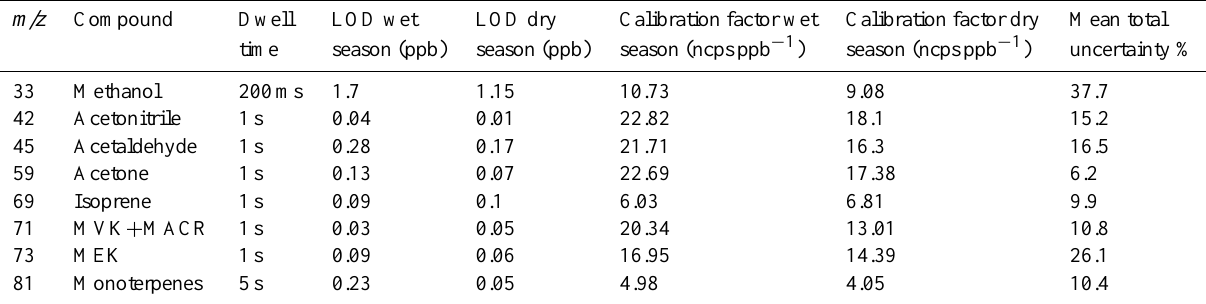
Table 1. Compounds calibrated for PTR-MS measurements with respective protonated mass-to-charge ( m/z ), PTR-MS dwell time and de- tection limit (LOD) for the wet and the dry season. In addition, the calibration factors (ncpsppb − 1 ) obtained are reported for the wet and dry season. Lastly, total PTR-MS uncertainty for both seasons is